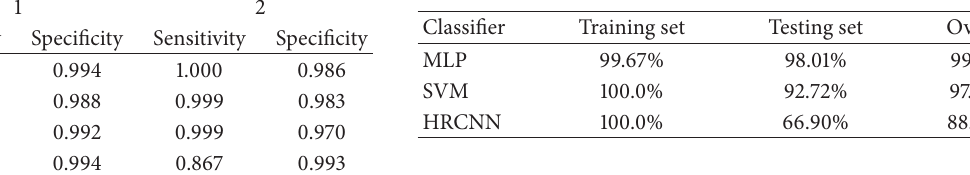
Table 2: The segmentation results. Table 3: The classification results of the three neural-network-based